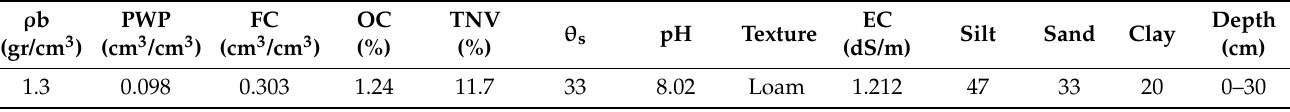
Table 1. Chemical and physical analysis of soil at a depth of 0–30 cm.